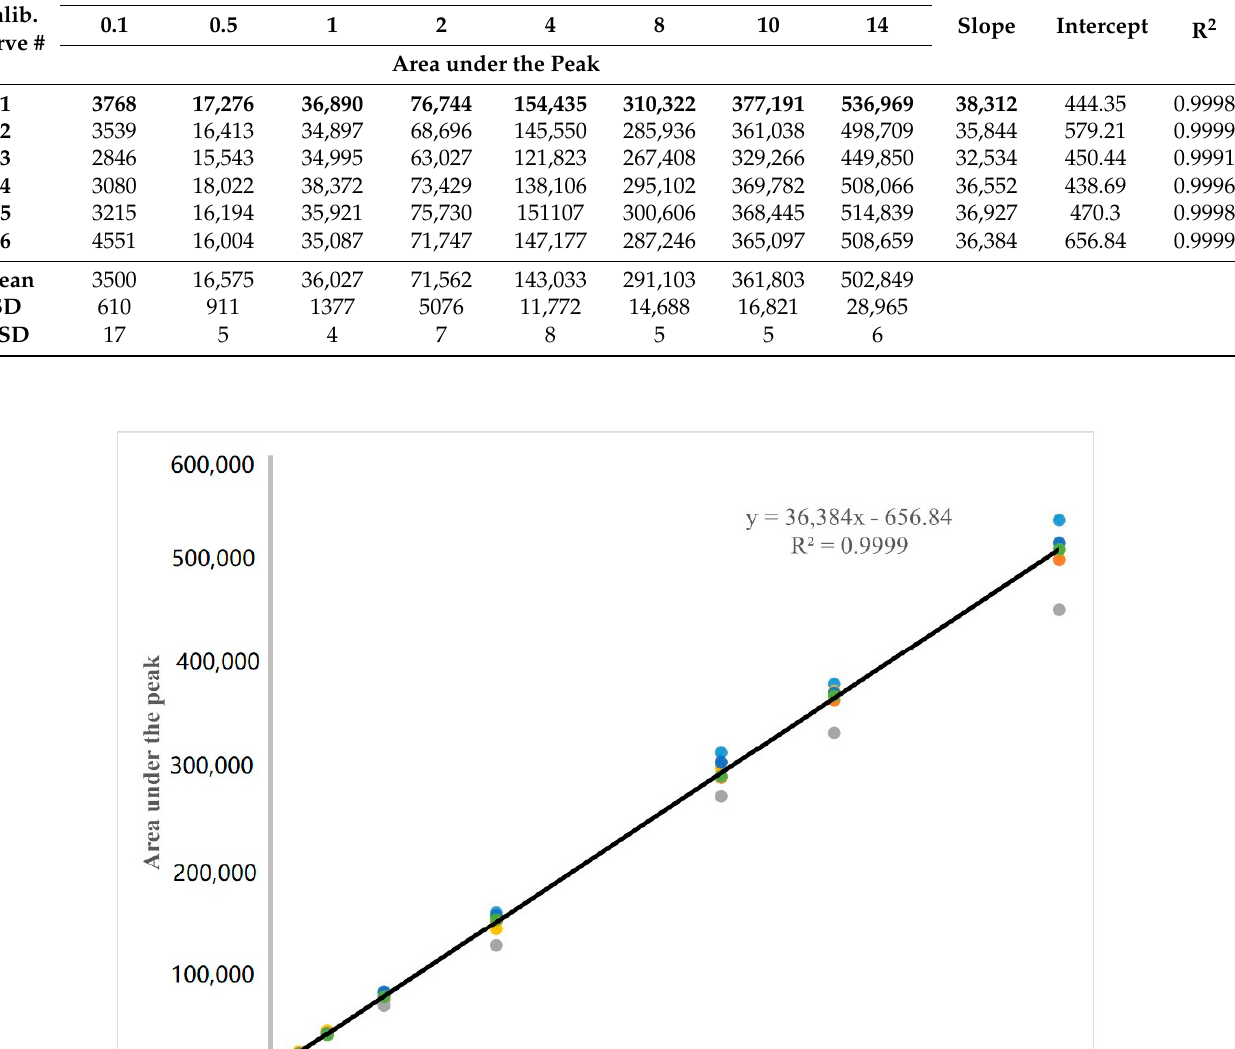
Table 1. Linearity of the RP-HPLC method for the determination of asenapine maleate in dissolution media (parameters of the calibration curves) (n = 6). Calib. Curve #